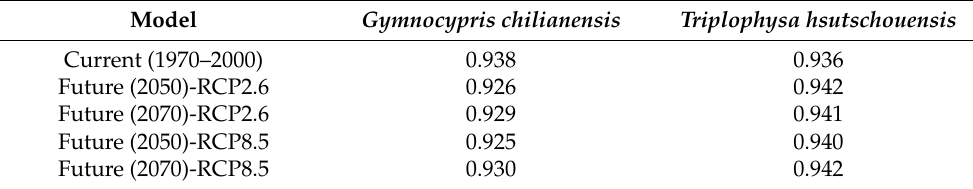
Table 2. Area under the curve (AUC) training values in the developing G. chilianensis and T. hsutschouensis distribution model under different climate scenarios.